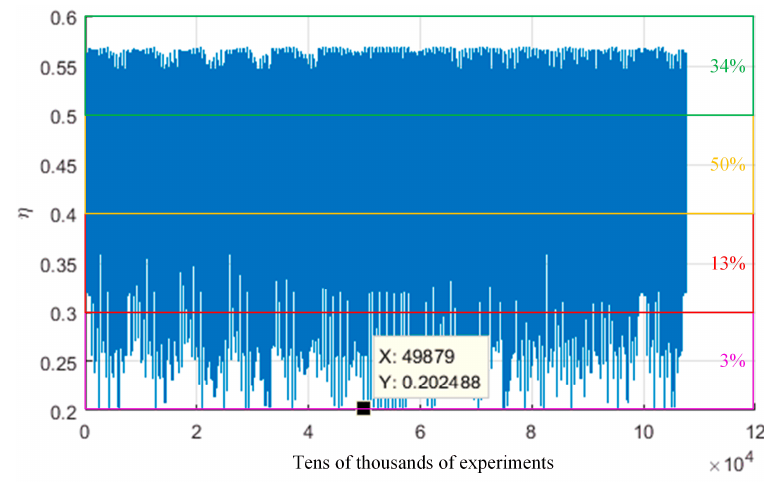
Figure 11. The power transfer efficiency versus the times of nested simulation.